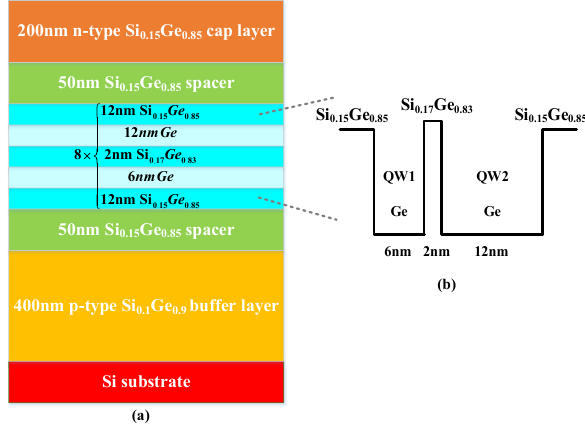
Figure 1: (a) Epitaxy design of the CQWs structure. (b) Schematic of the asymmetric